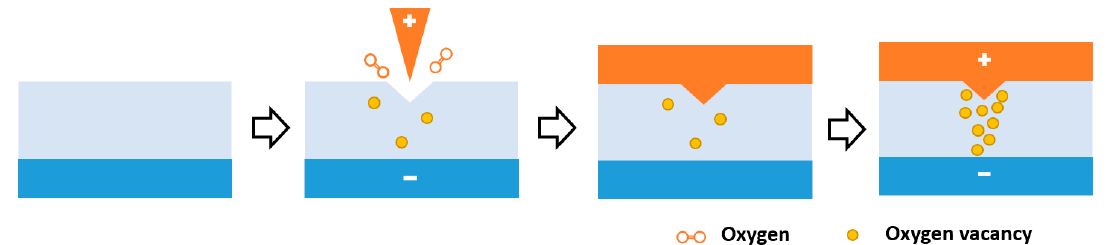
Figure 1. Flow chart of device fabrication assisted by scanning probe microscope technique.